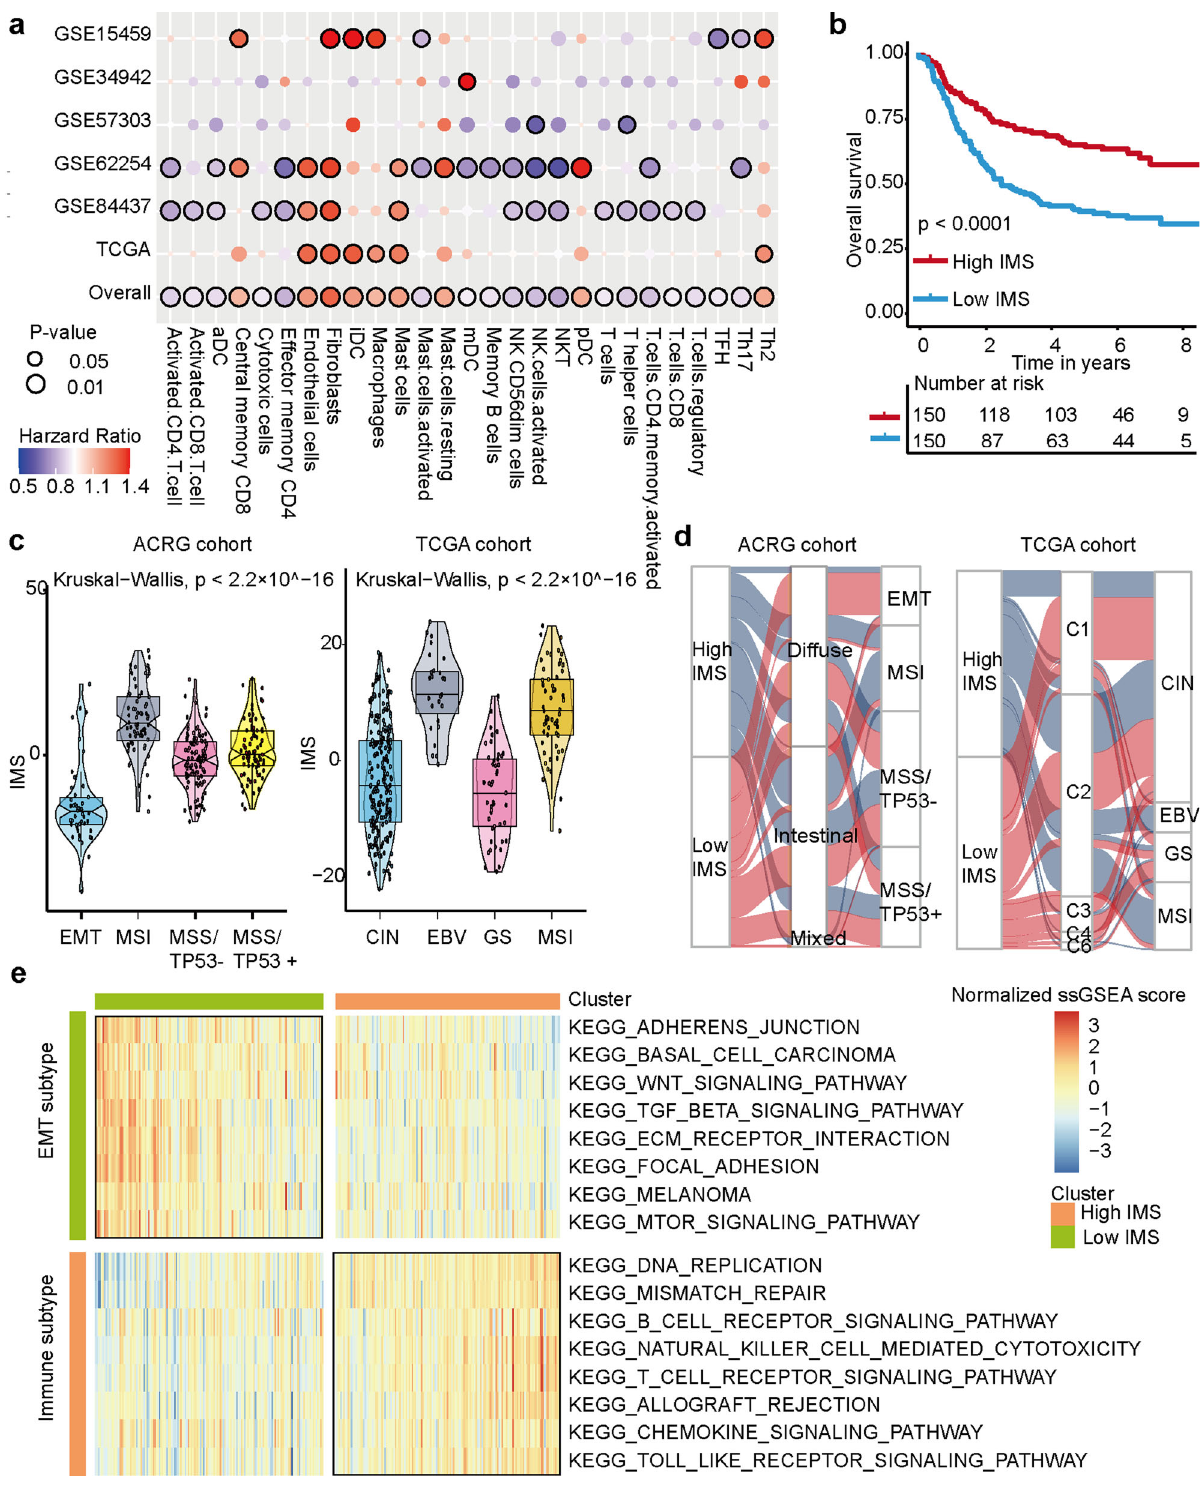
Fig. 1 The distribution of the IMS in gastric cancer. a Immune cell types that have survival signi fi cance in gastric cancer. A meta-analysis was used to evaluate the overall survival effect of each immune cell type. Circles with a black border represent survival signi fi cance in an independent cohort as determined through univariate Cox analysis. Red points indicate an HR value >1, implying a potential risk factor. Blue points indicate an HR value less than 1, implying a potential favorable factor. The size of the circle represents the level of the HR. b Kaplan – Meier curve of OS according to the IMS in the ACRG cohort (log-rank test, P value < 0.0001). c The relationship between gastric cancer subtypes and the IMS (Kruskal – Wallis, P value < 2.2 × 10 – 16 ). The central line represents the median value. The bottom and top of the boxes are the 25th and 75th percentiles (interquartile range). The whiskers encompass 1.5 times the interquartile range. d Sankey diagram showing the relationship between the IMS and gastric cancer subtypes. e KEGG pathways enriched in the high and low IMS groups were analyzed by GSVA. Heatmaps were used to visualize these signaling pathways. * P < 0.05, ** P < 0.01, *** P < 0.001, **** P <